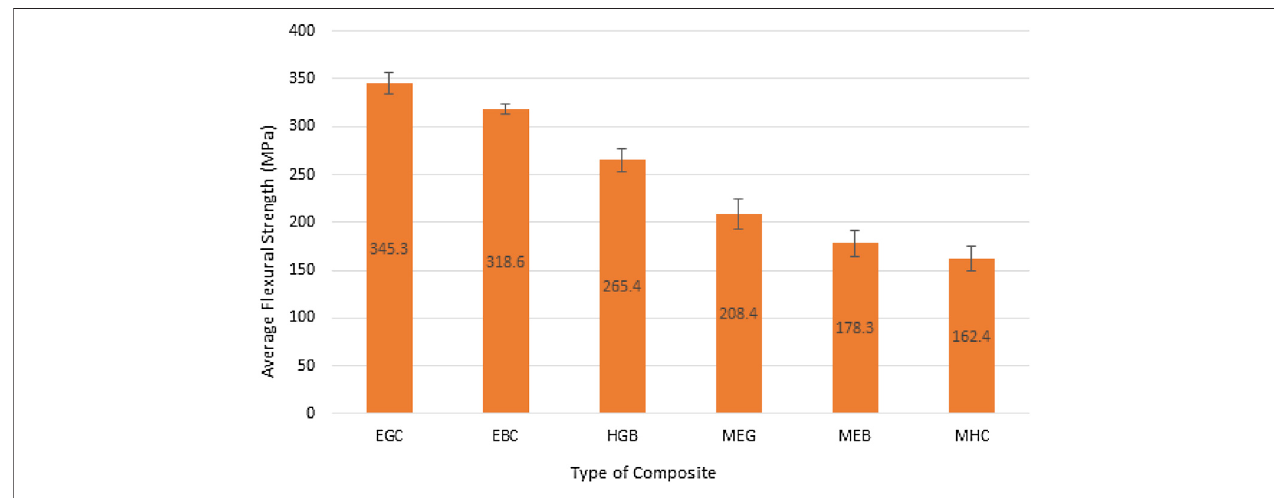
FIGURE 3 | Flexural strength of different composites.